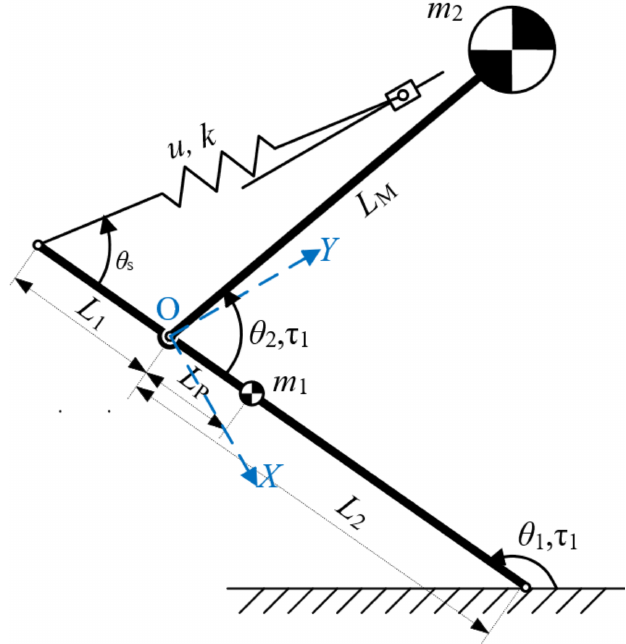
Figure 6. Dynamic model of proposed mechanism for ejection process. Lagrange dynamical equations are set up to carry out dynamical analyses. Here τ 1 refers to values of torques on the point where the pole contacts with the ground, and τ 2 refers to torque on the point